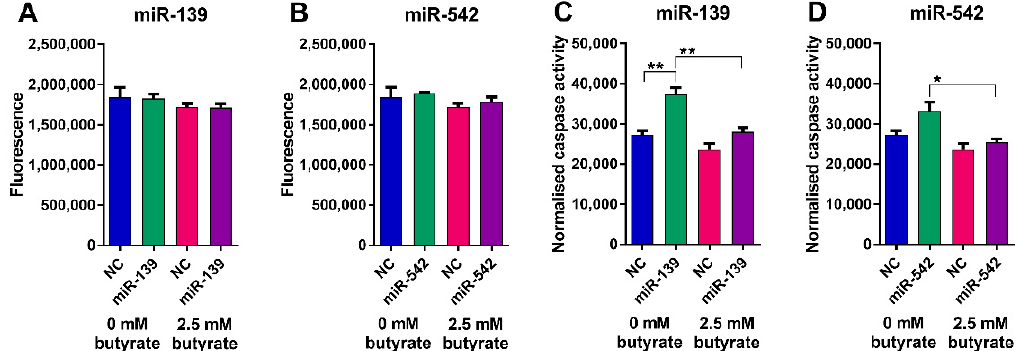
Figure 11. Cell viability and apoptosis in miRNA-transfected HFF cells after 24 h of butyrate treatment. ApoLive-Glo™ multiplex assay: fluorescence and luminescent signals for viability changes ( A ) miR-139, ( B ) miR-542 and normalized caspase activity for apoptosis changes, respectively ( C ) miR-139, ( D ) miR-542 in HFF cells transfected with butyrate-sensitizing miRNAs for 48 h, followed by 24 h of treatment with 0 mM or 2.5 mM butyrate, over a 72 h post-transfection period. Significant results are indicated by * p < 0.05, ** p < 0.01. NC = negative control mimic.